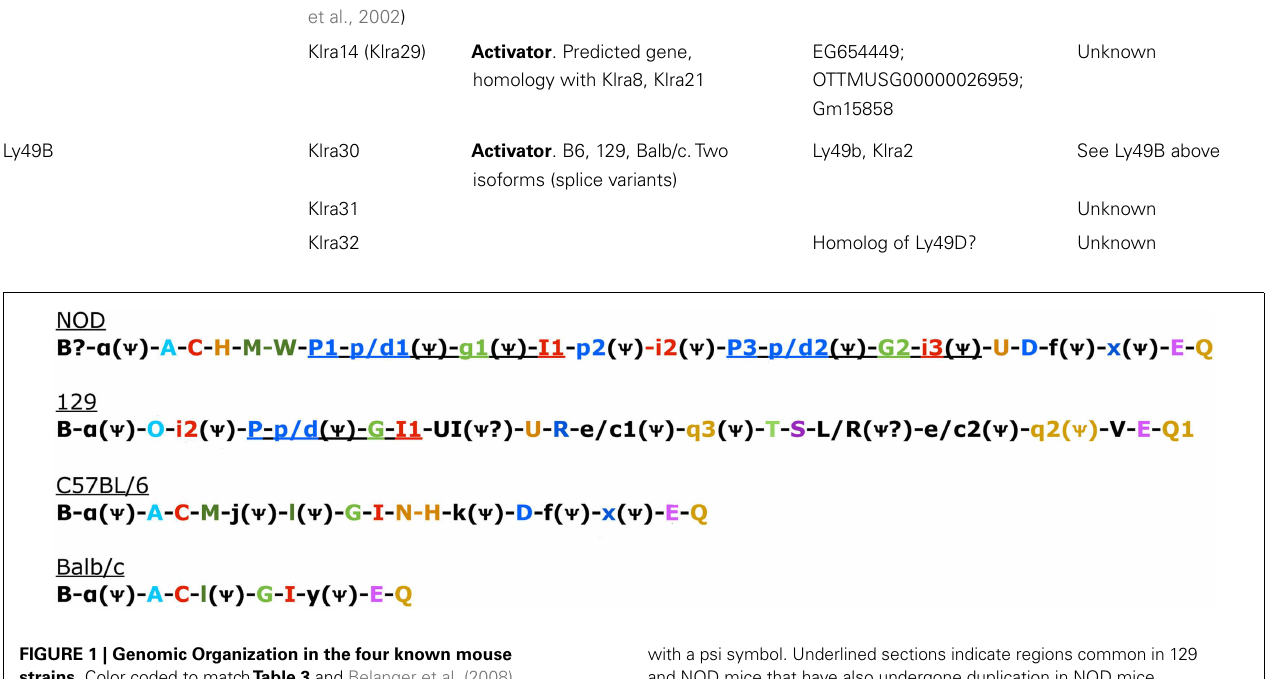
FIGURE 1 | Genomic Organization in the four known mouse strains. Color coded to match Table 3 and Belanger et al. (2008). Uppercase gene is known to be expressed. Pseudogenes indicated